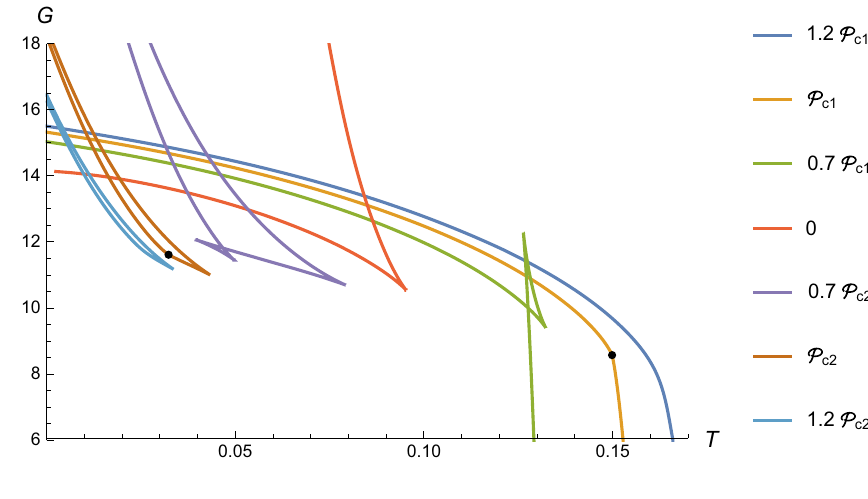
Fig. 4 G – T diagram of charged dilatonic AdS black hole with N = 2 , D = 6. We set the electric charge Q = 10. The black points represent the critical